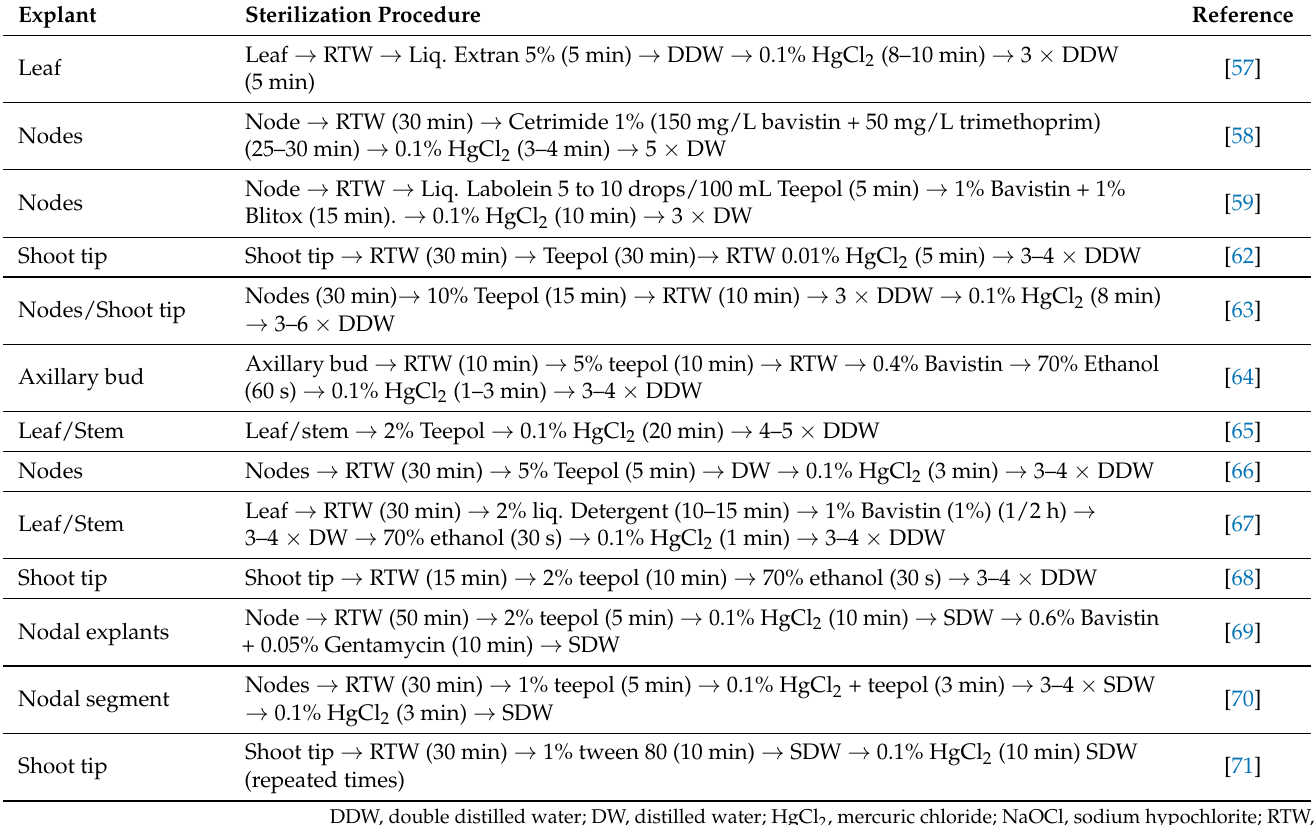
Table 3. Explant disinfection procedure in C. asiatica